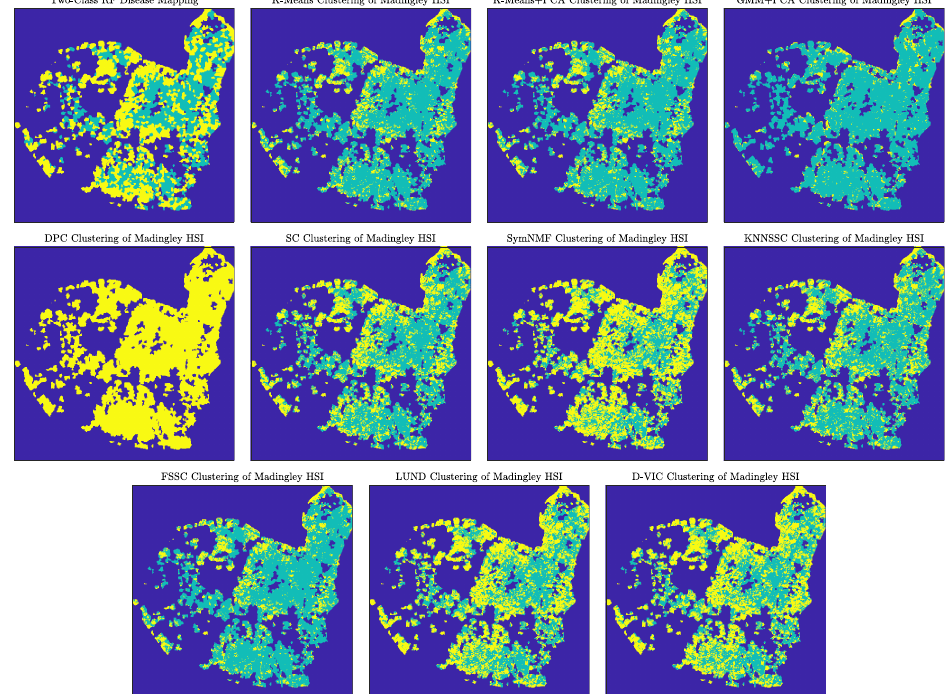
Figure 11. Comparison of clusterings produced by D-VIC and related algorithms on the Madingley HSI. Labels were aligned so that yellow indicates dieback-infected ash and teal indicates healthy ash. Though the performance of many graph-based algorithms (SC, KNN-SSC, LUND, and D-VIC) was similar in Table 4, qualitative differences exist between these algorithms’